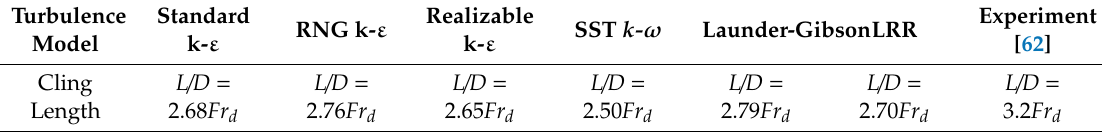
Table 4. Cling length relationship for the various turbulence models of Gildeh et al. (2014a).